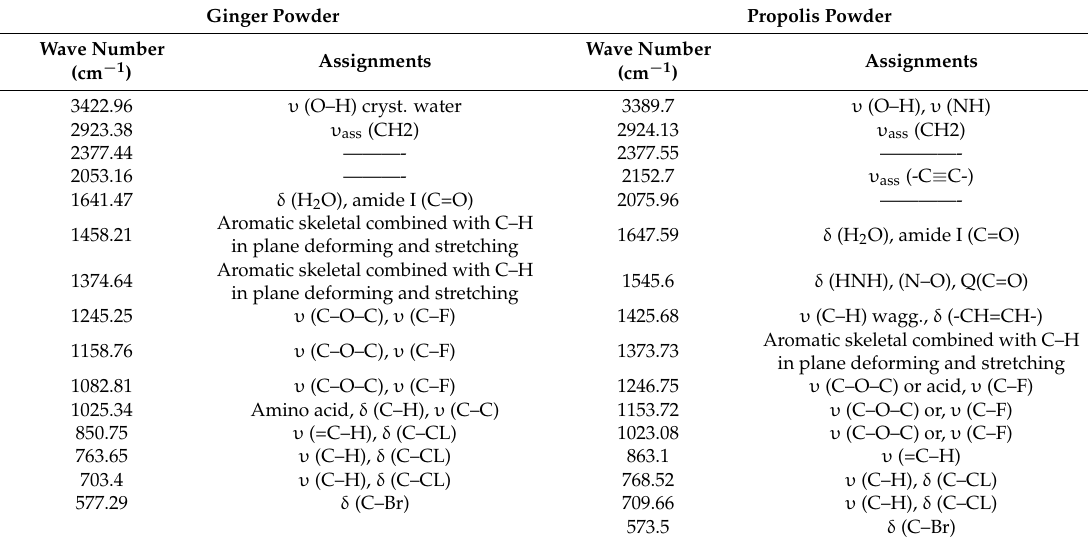
Figure 1. Fourier transform infrared spectra (FTIR) of ginger and propolis in the range of 400–4000 cm − 1 . Table 1. Wave number assignments of FTIR spectra of ginger and propolis powder.